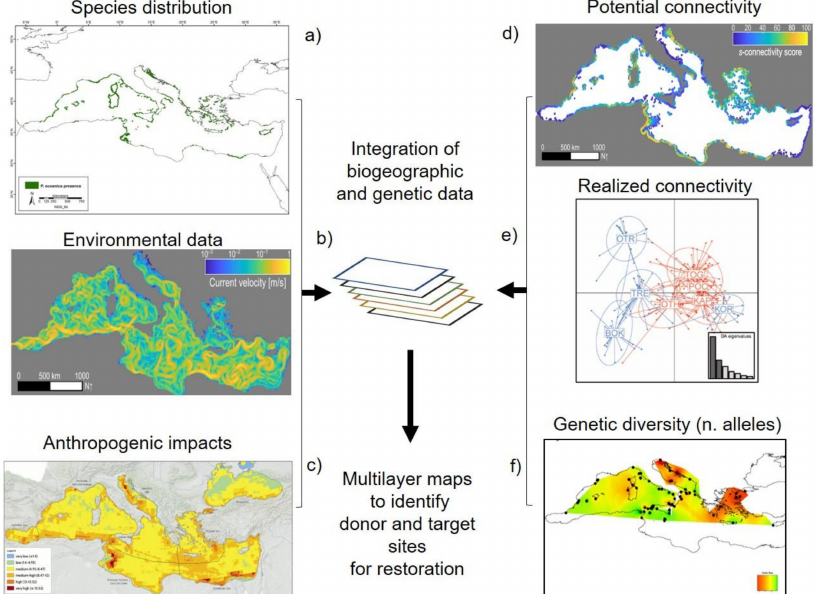
Figure 3. Examples of models and distributions maps and genetic data from seagrass’ studies of the Mediterranean Sea. The integration of species distribution ( a [119]), environmental data ( b [58]), anthropogenic impacts ( c [120]), with potential ( d [58]) and realized connectivity maps ( e [57]) and genetic diversity analysis ( f [121]) could be combined to develop multilayers maps for the identifications of donor and target sites in seagrass restoration (see text for more detail). The figure was modified from the studies cited